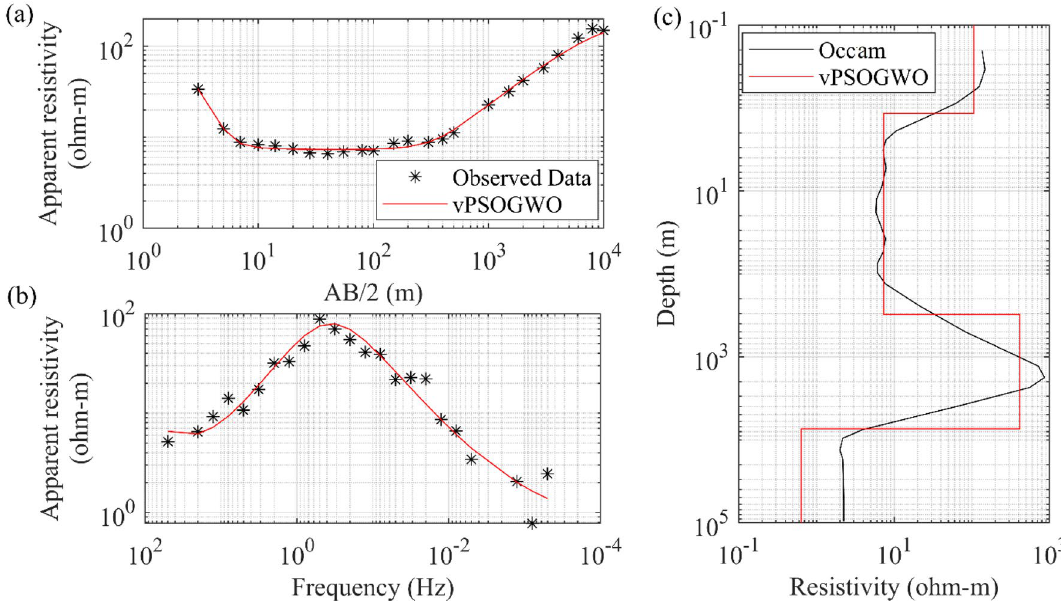
Figure 17. Four-layers DC and MT field data near Broken Hill in South Central Australia for joint inversion: ( a ) DC observed (*) and the best-fitted apparent resistivity curves, ( b ) MT observed (*) and the best-fitted apparent resistivity curves, ( c ) 1D mean model (bpdf > 68.27% CI) inverted by vPSOGWO scheme